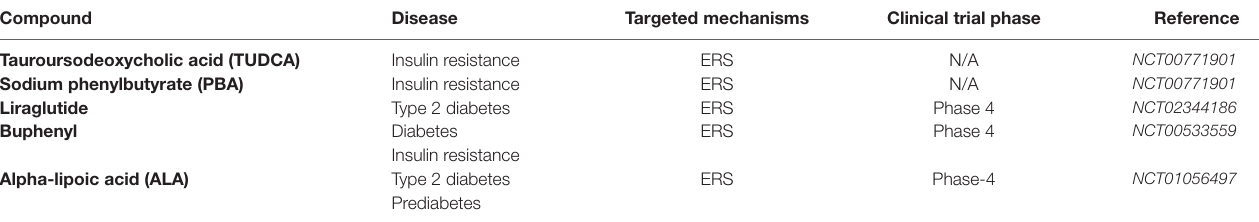
TABLE 4 | Clinical trials of therapeutics targeting ERS and UPR. Compound Disease Targeted mechanisms Clinical trial